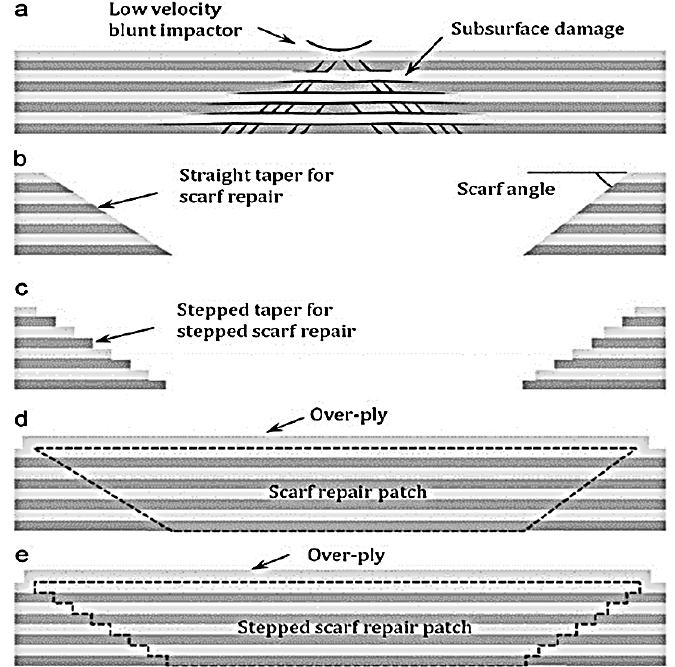
Figure 5. Bonded composite restoration: ( a ) subsurface deformation usually prompted by low velocity dull impactor; ( b , c ) composite machining to achieve level and stepped taper for scarf and stepped scarf restoration; ( d , e ) scarf and stepped scarf remedial patches. Reproduced with permission from ref. [37].